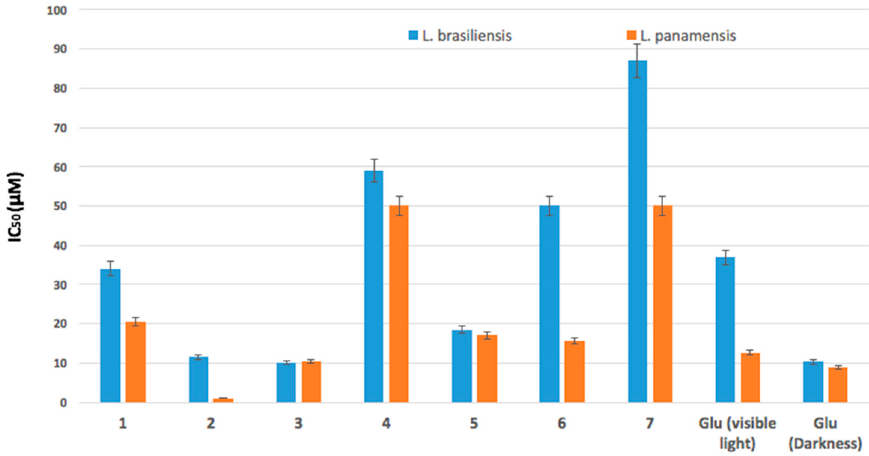
Figure 2. IC 50 values for photoinactivation of L. braziliensis and L. panamensis promastigotes after 24 h of incubation in the presence of ( 1 – 7 ) and the positive control under light irradiation. Table 2. IC 50 values for photoinactivation of L. braziliensis and L. panamensis promastigotes in the dark and under visible irradiation.